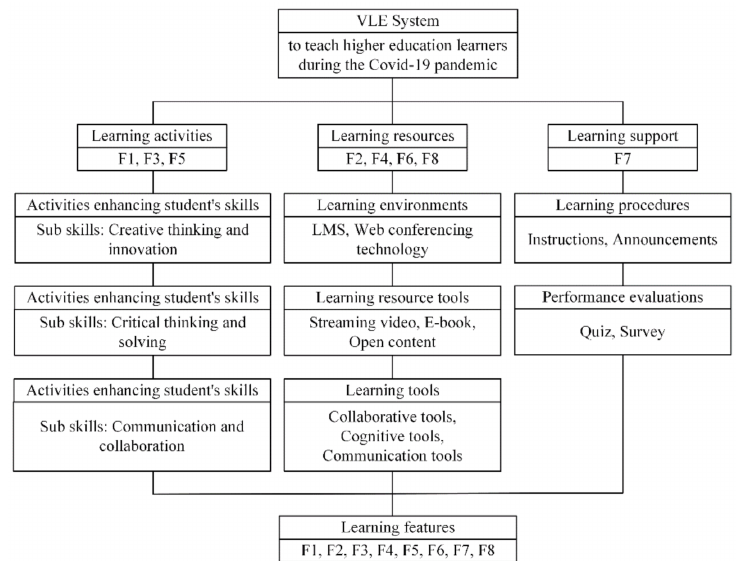
Figure 2. Teaching design in a virtual learning environment (VLE) system involves relationships among the major elements including learning activities, learning resources, and learning support. Learning features are denoted as F1, F2, F3, F4, F5, F6, F7, and F8, corresponding to the